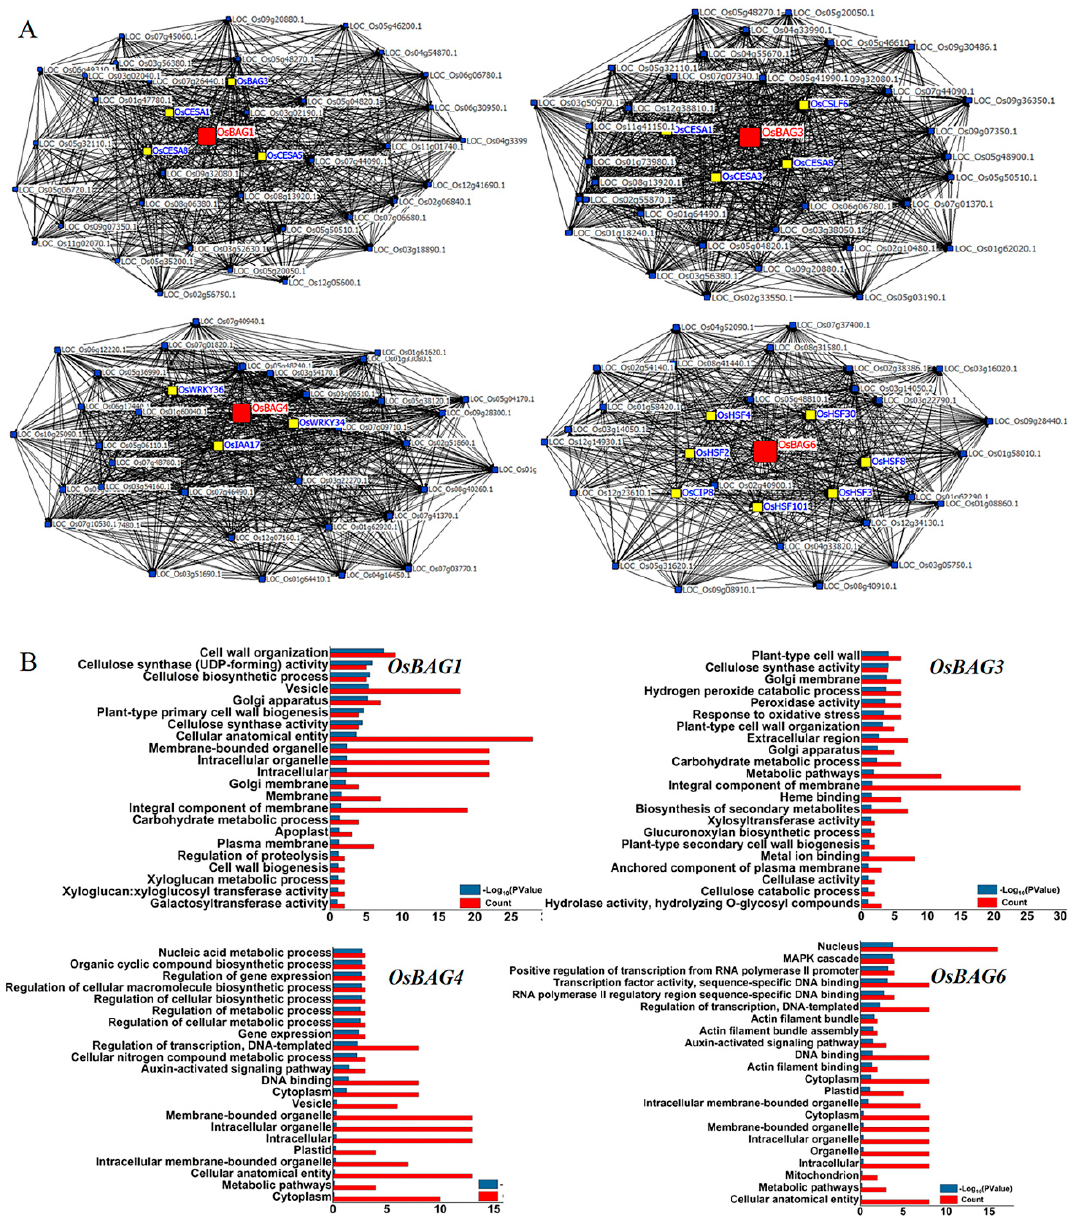
Figure 3. OsBAG co-expression profiling and the functional relevance analysis. ( A ) Co-expression gene vicinity network for OsBAGs . Four co-express networks were constructed with the top 20 co-expressed genes of each OsBAG (selected from the top 100), which clearly displayed the tight co-expression relationships between the genes. ( B ) Gene Ontology (GO) analysis of OsBAG genes.